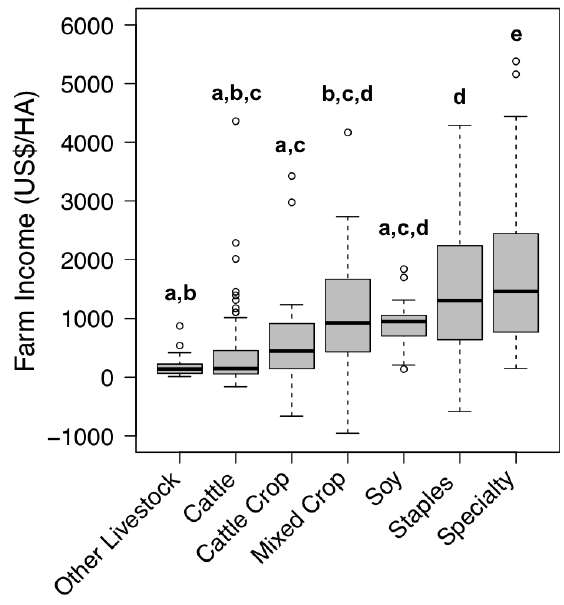
Fig. 3 . Farm income (US$/HA) by land use. Farm income is highest for households specializing in specialty crop production (mean income = US$3304), followed by staple cropping (US$1753), and lowest among households specializing in cattle (US$372) and noncattle (US$195) livestock production. Soy properties earn moderate incomes (US$926). The box plots encompass the first and third quartiles, with the central bar depicting the median. Outliers greater than 1.5 times the interquartile range are suppressed. Means with the same lowercase letter at the top of the graph are not significantly different at the 95% level, based on post-hoc Tukey